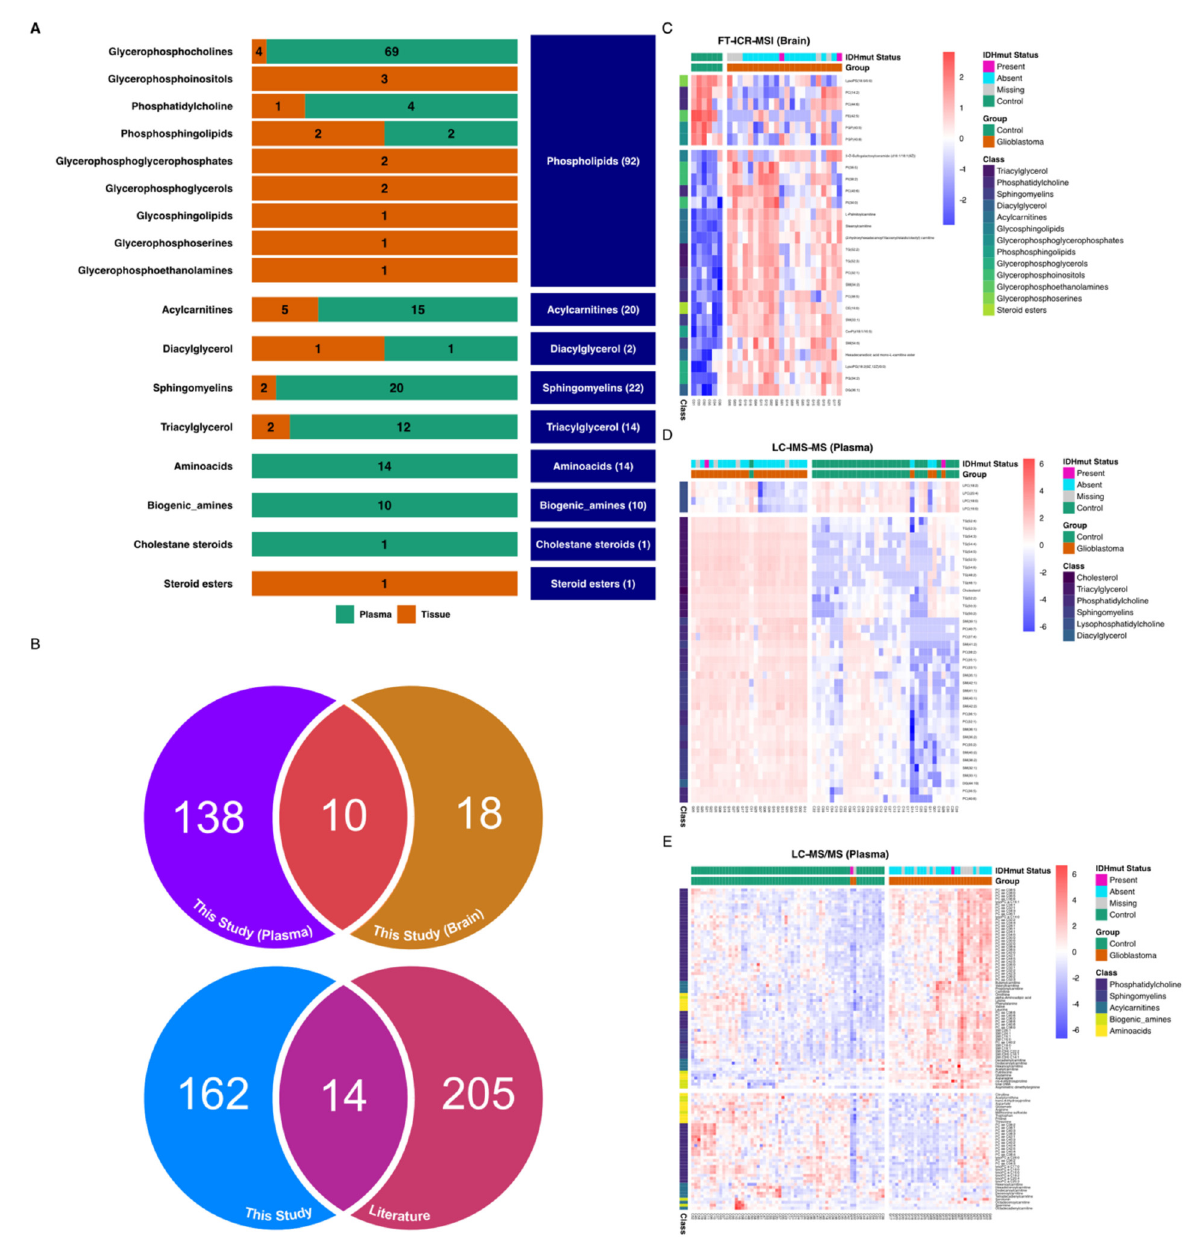
Figure 3. Differential analysis overview. ( A ) Differential analysis results between control and glioblastoma samples highlighting metabolic classes. One hundred and seventy-six metabolites were identified based on an adjusted p -value of 0.05. One hundred and forty-eight plasma-based metabolites and 28 Tissue-based metabolites. ( B ) Upper: Ven diagram representation of the overlap between the identified differentially expressed metabolites in Plasma versus Brain. Lower: Ven diagram representation of the overlap between the identified differentially expressed metabolites in this study versus reported human metabolomics-based GBM reported literature. ( C ) Heatmap showing the relative levels of statistically differential metabolites in different patients’ tissues using FT-ICR-MS data. ( D ) Heatmap showing the relative levels of statistically differential metabolites in different patients’ plasma using LC-IMS/MS data. ( E ) Heatmap showing the relative levels of statistically differential metabolites in different patients’ plasma using LC-MS/MS data. Detailed results are presented in Table